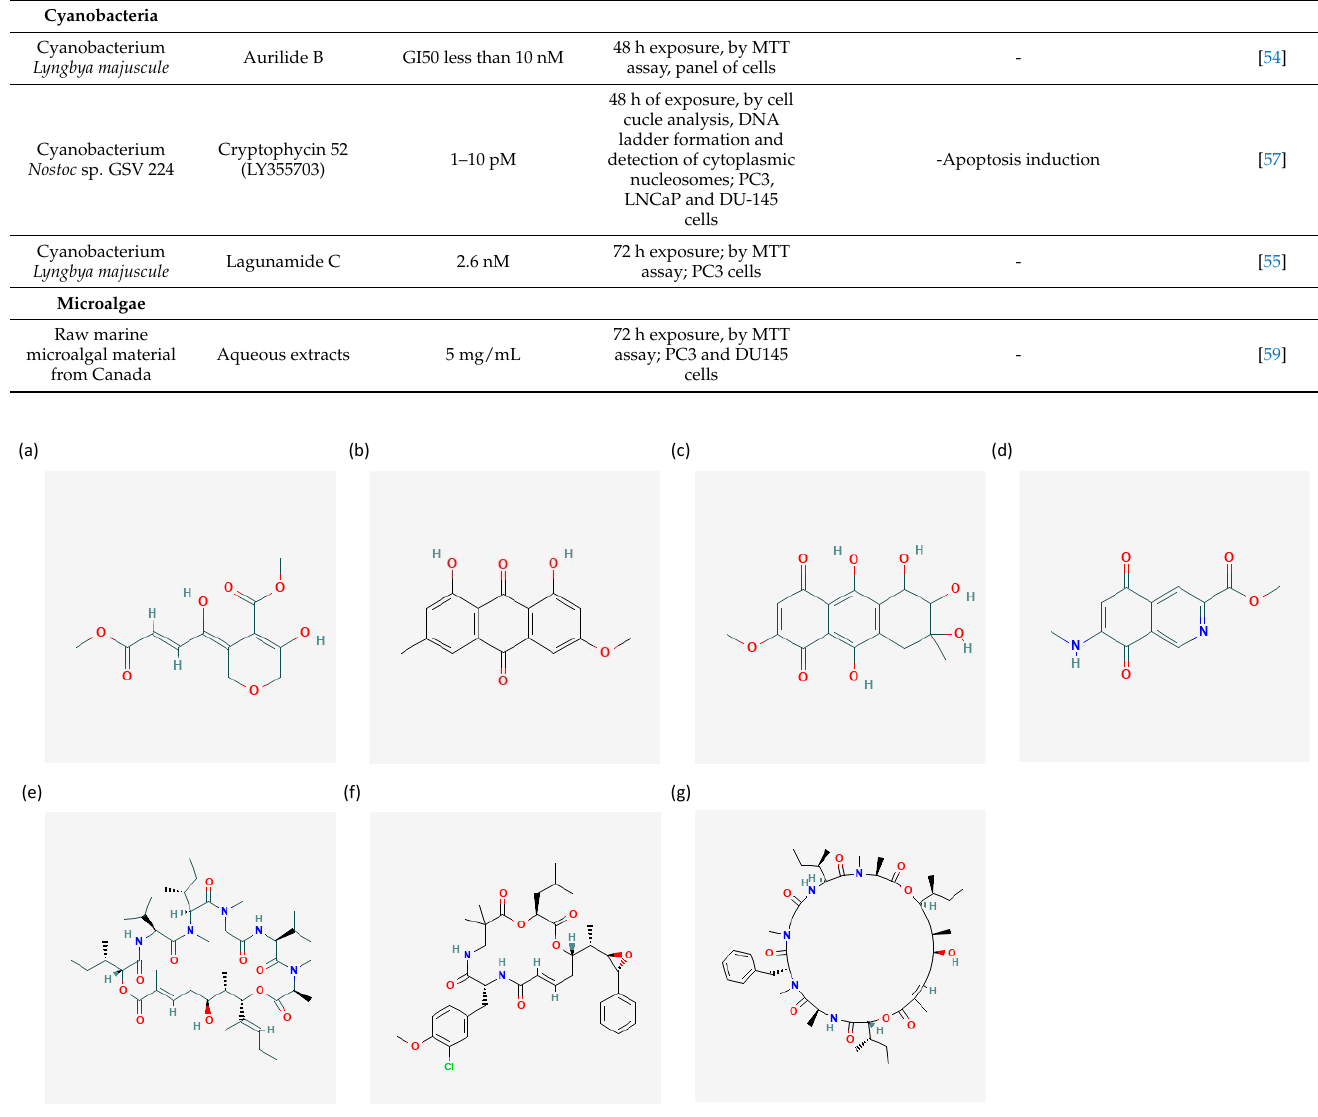
Figure 4. The figure shows chemical structures of ( a ) isariketide B [60], ( b ) physcion [61], ( c ) SZ-685C [62], ( d ) mansouramycin C [63], ( e ) aurilide B [64], ( f ) cryptophycin 52 (LY355703) [65], ( g ) lagunamide C [66]. Chemical structures are retrieved from the public database PubChem